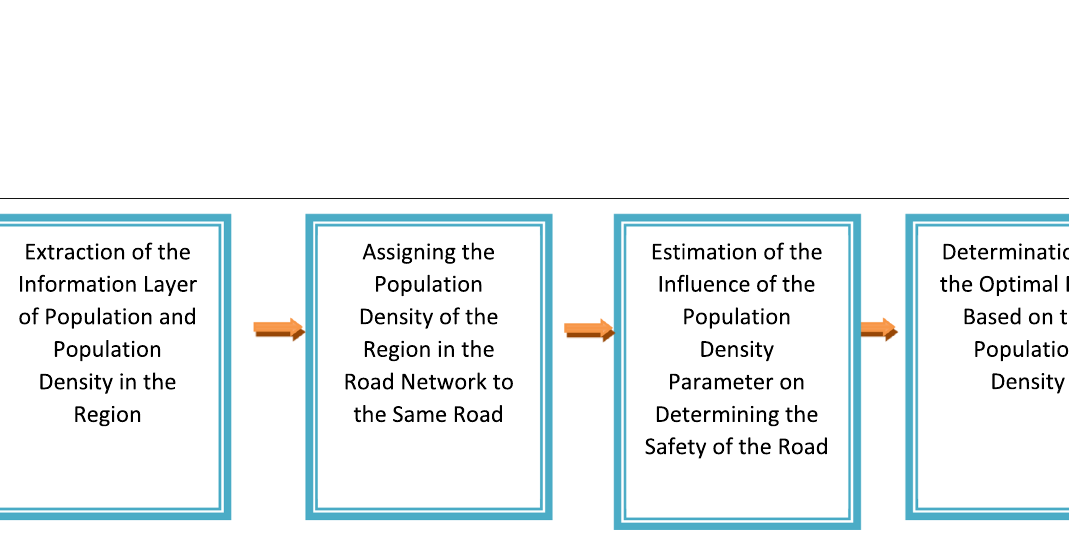
Fig. 7 Estimating population density index method and its optimal road